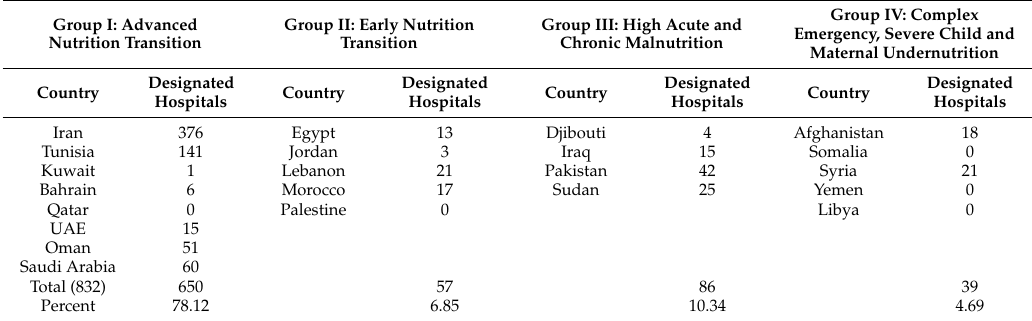
Table 1. Status of the Baby-Friendly Hospital Initiative by number of designated hospitals in each country grouped by their nutrition stages and with dominant nutrition problems